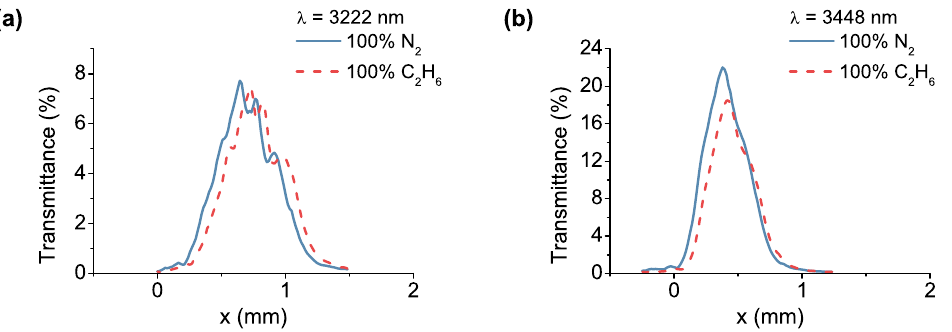
Figure 11. Measured spectral response of the gas-filled LVOF with nitrogen and ethane at the wavelengths of ( a ) 3222nm and ( b )